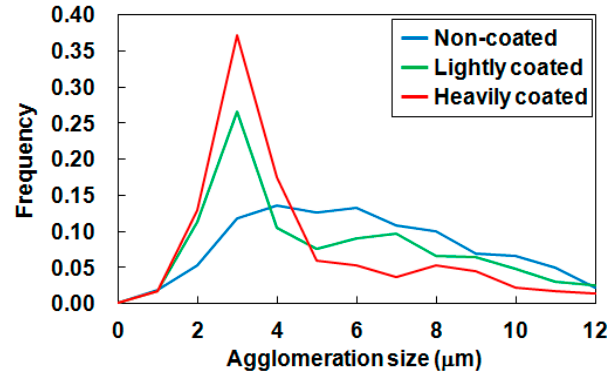
Figure 3. Agglomerate size distributions for the non-coated, lightly fatty acid-coated, and heavily fatty acid-coated CaCO 3 particles.